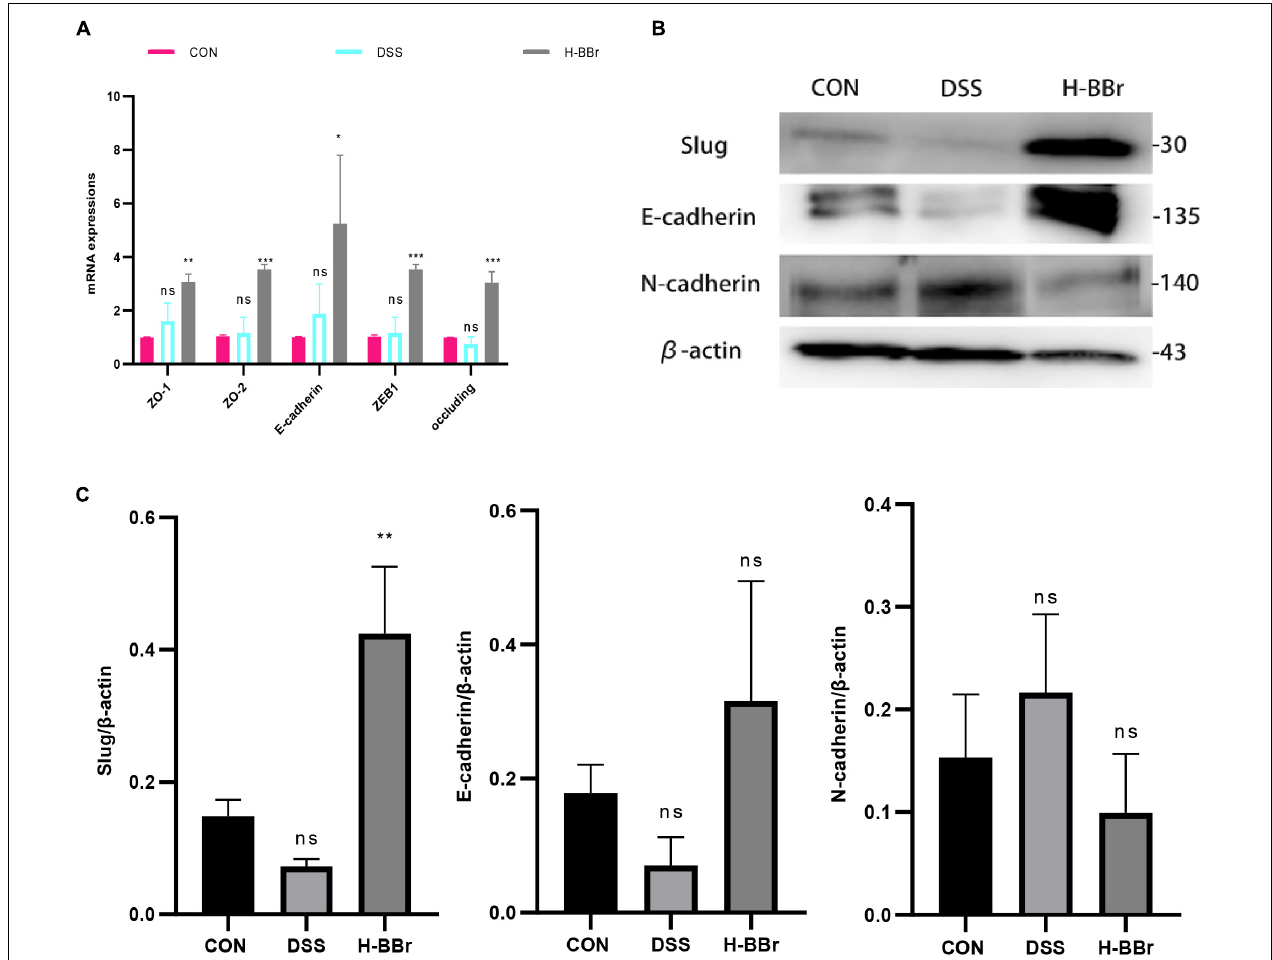
FIGURE 2 | BBr repairs DSS – induced intestinal mucosal barrier injury. (A) Histogram of the mRNA relative expression in colonic mucosa. (B) Western blot assay of E-cadherin, N-cadherin, and slug. (C) One-way ANOVA and Tukey’s post-test analyze the protein gray value of E-cadherin, N-cadherin, and slug. Data represent the mean ± SD . P < 0.05 was considered statistically significant. * P < 0.05, ** P < 0.01, *** P < 0.001 vs CON